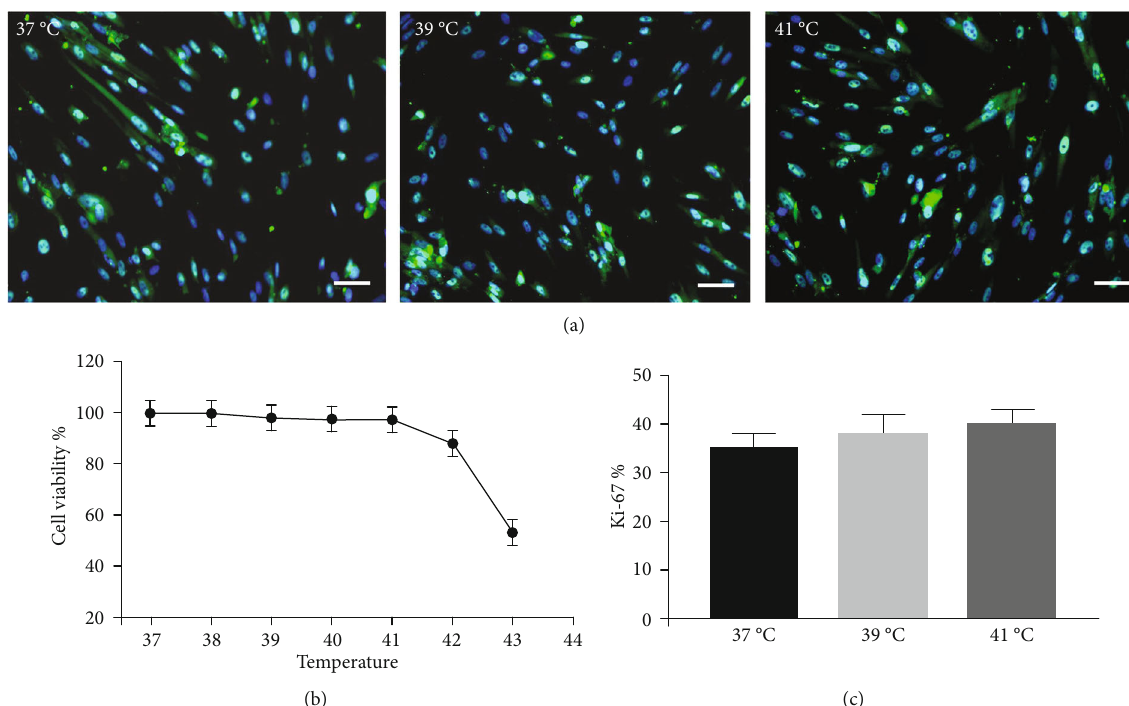
Figure 2: E ff ect of heat stress at di ff erent temperatures on EMSC proliferation. After 72 hours of treatment with heat stress, (a) Ki-67 expression was determined using immuno fl uorescence staining, and 200 cells cultured under each condition from at least 6 independent fi elds were counted. Ki-67-positive cells are presented as a percentage of the total population. (b) Cell proliferation was measured using the CCK-8 assay. (c) Graphs showing the percentage of Ki-67-positive cells, bar = 25 μ m